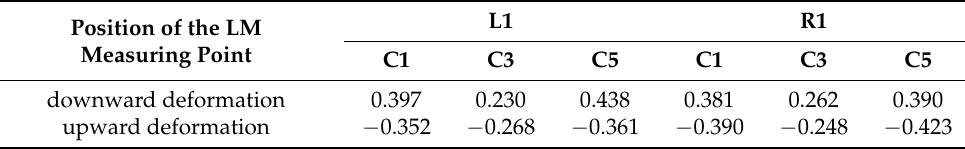
Table 1. Maximum local deformation amplitudes of the L1 and R1 LMs on the 650 m radius curve (unit: mm, V = 93 km/h).